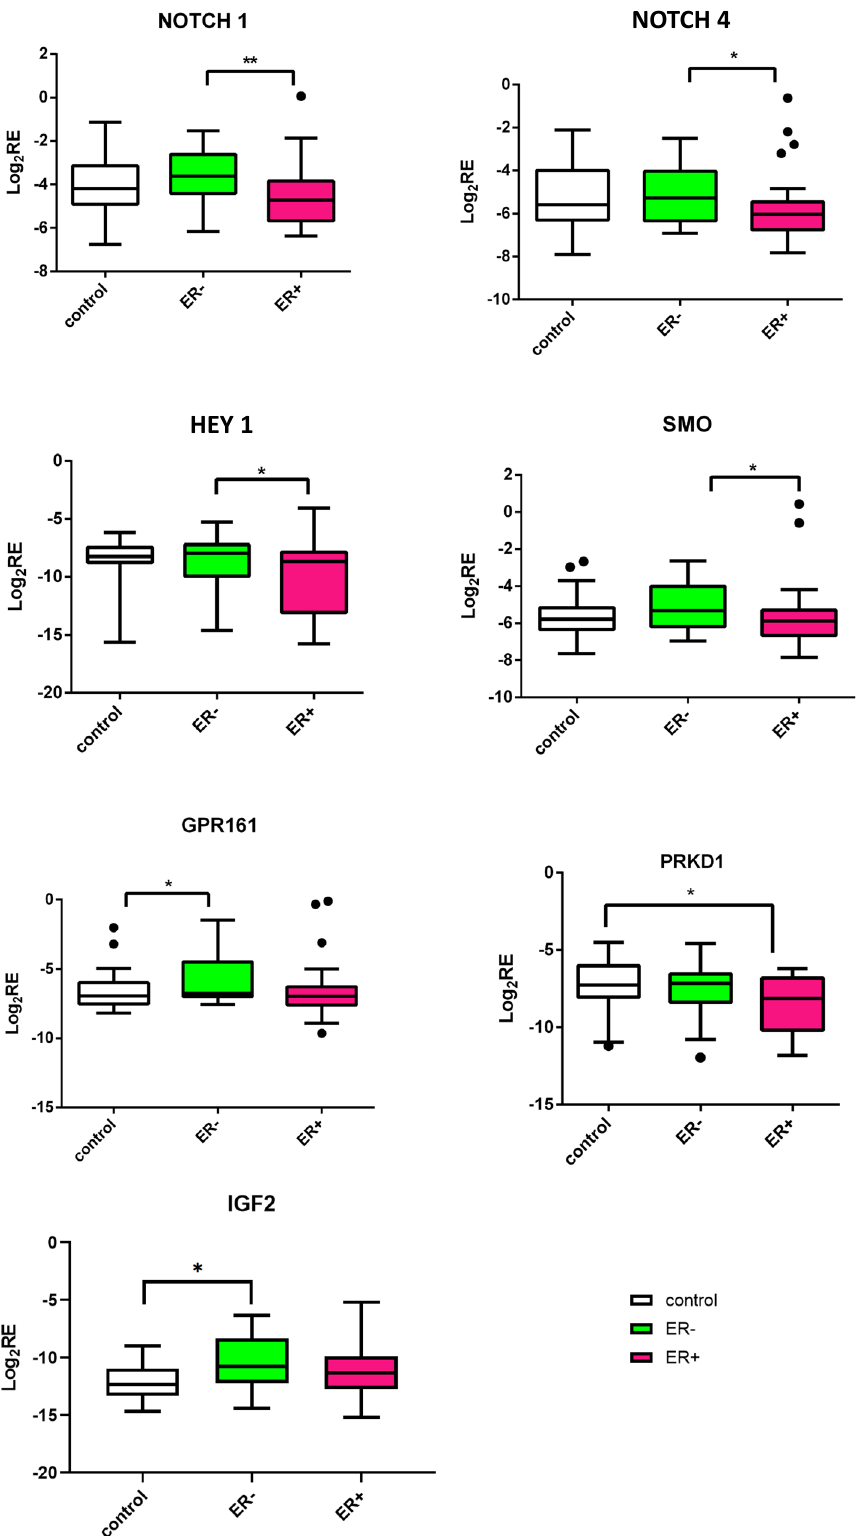
Fig. 3 Notch pathway is overexpressed in CUB samples of patients at high risk of ER − disease. Expression of genes from various pathways in matching CUBs from ER-negative, ER-positive patients, and controls. The log2-transformed relative (log2RE) amounts of mRNA expression normalized to the housekeeping gene and expressed as log 2 2 − (CtX − CtGAPDH) = − (CtX − Ct GAPDH) where Ct is threshold cycle and X is gene of interest. IGF2 and GPR161 were signi fi cantly higher in ER-negative versus control. Genes from the Notch pathway were signi fi cantly higher in ER negative CUBs in comparison to ER positive patients. Mann – Whitney test was used to test the pairwise differences between the samples (ER + , ER − , Control) * P < 0.05; ** P < 0.01. Boxplots show mean and SEM with whiskers indicating 1 – 99th